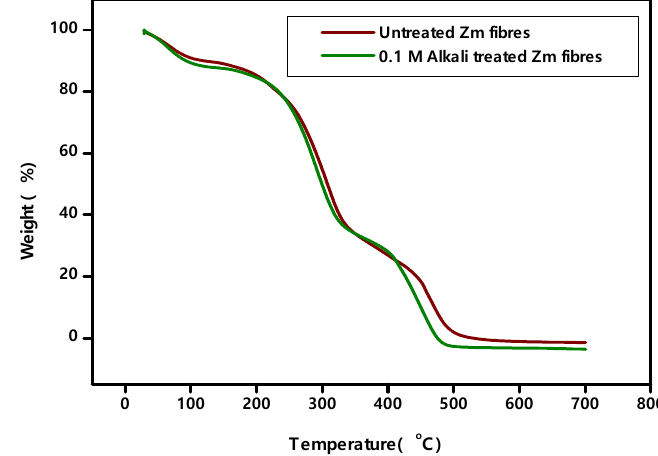
Polymers 2023 , 15 , x FOR PEER REVIEW